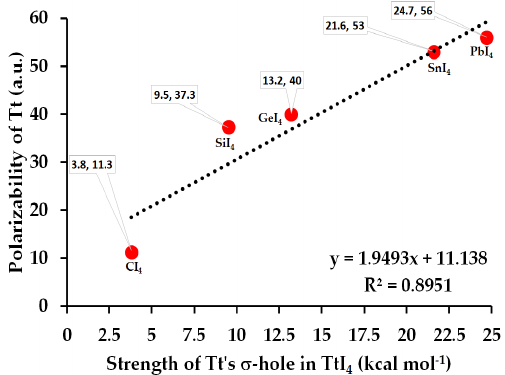
Figure 3. The dependence of polarizability of Tt derivative on the strength of the σ -hole on Tt in TtI 4 , computed using [ ω B97X-D/def2-QZVPPD]. The (polarizability, σ -hole) data for each molecule are indicated. The square of the regression coefficient R 2 is shown, together with the linear equation that connects polarizability with the strength of the σ -hole.